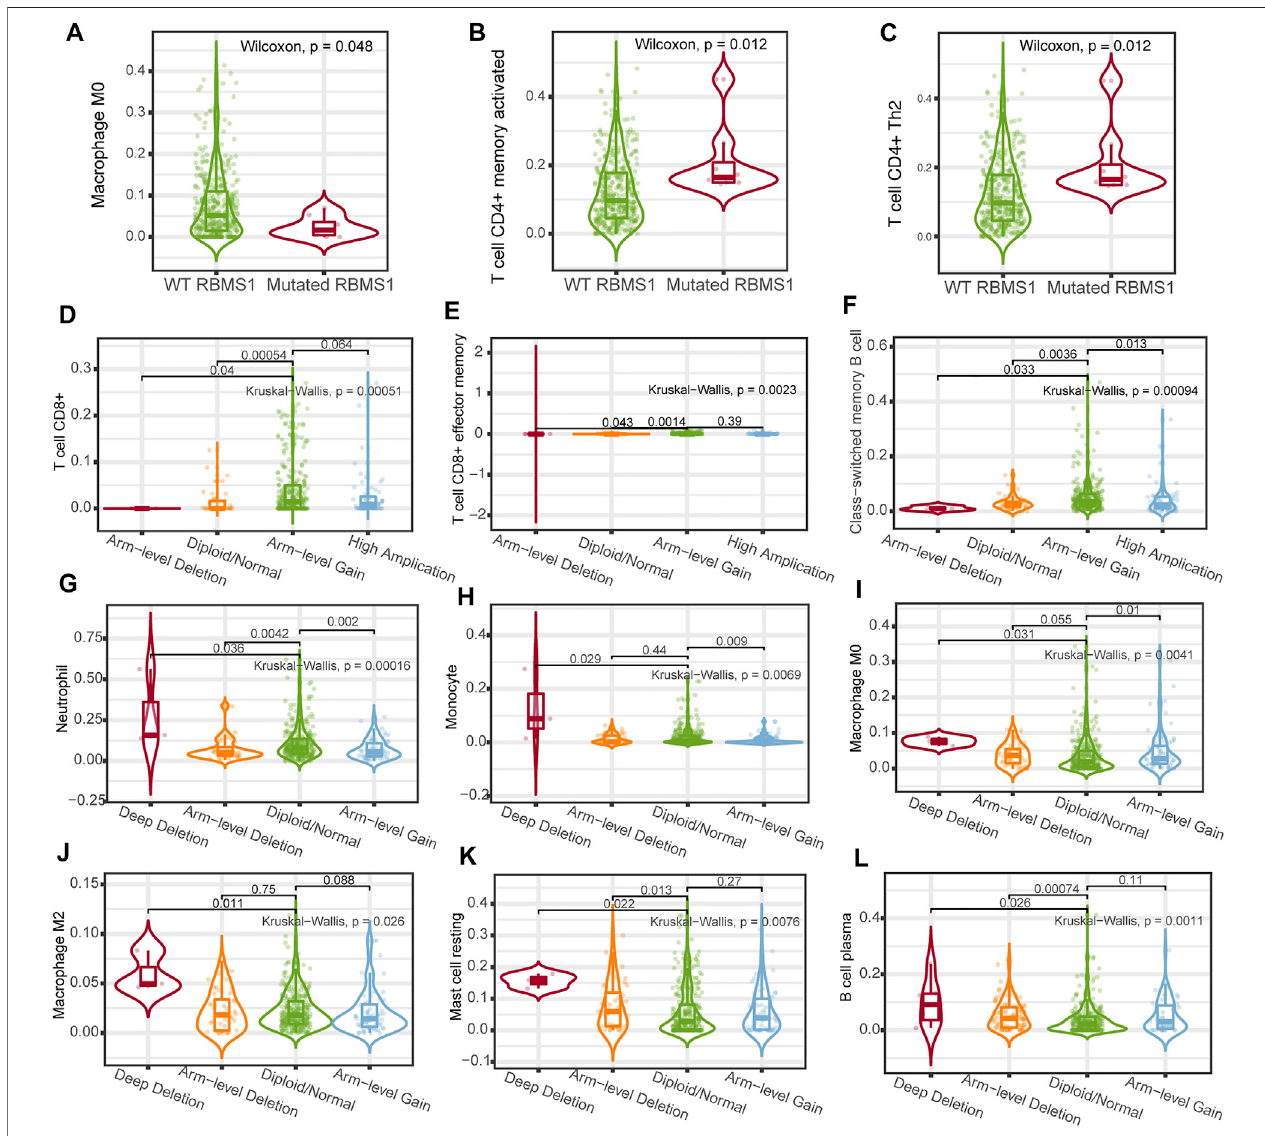
FIGURE8| Associationbetweenimmunecellin fi ltrationandgenomicdataoftheKCNQ1OT1/RBMS1axis. (A – C) Associationbetweenimmunecellin fi ltrationand RBMS1 mutation. (D – K) Relationship between immune cell in fi ltration and sCNA ofRBMS1. (L) Relationship between immune cell in fi ltration and sCNA of KCNQ1OT1.